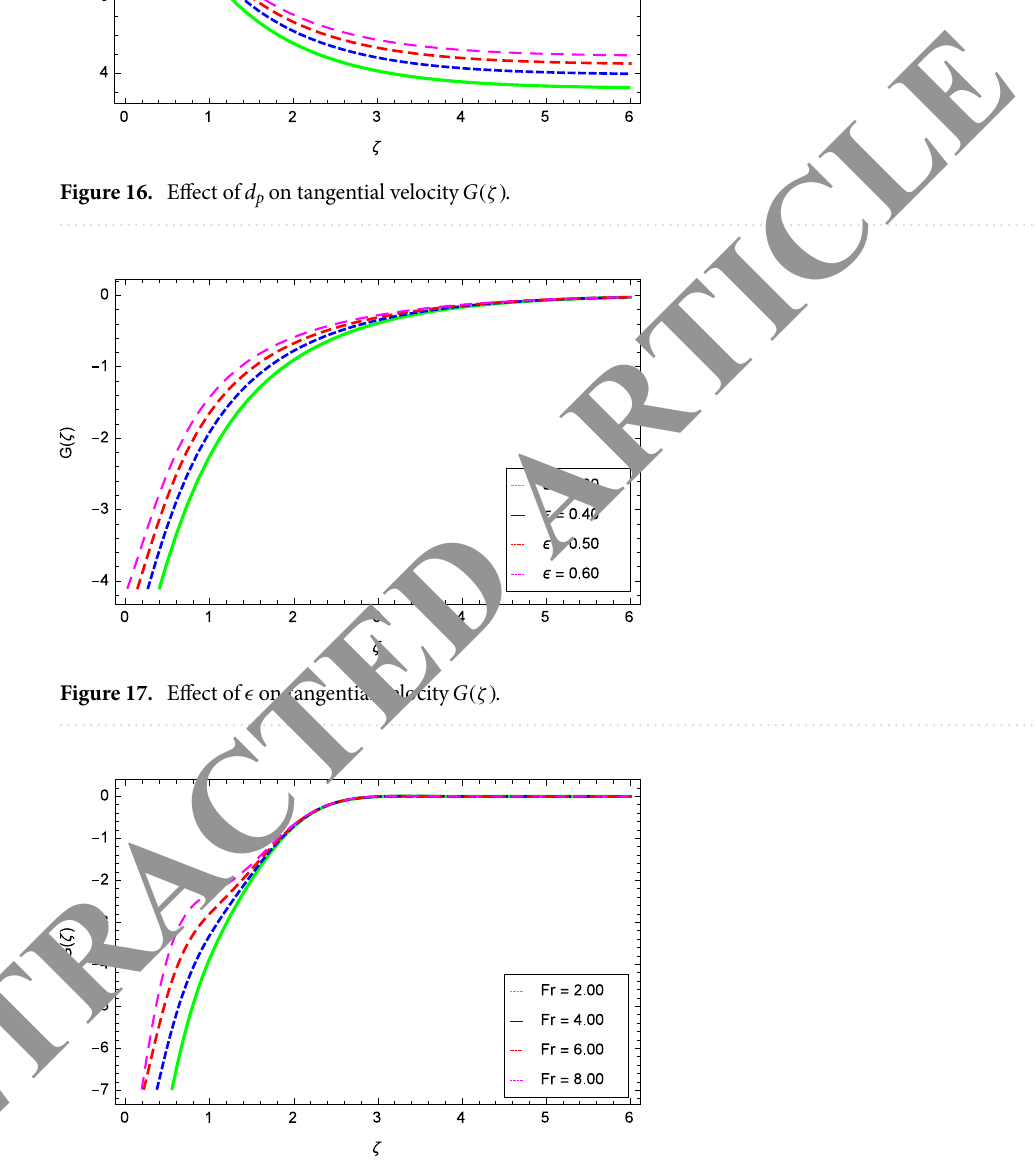
Figure 18. Effect of Fr on tangential velocity G (ζ) .